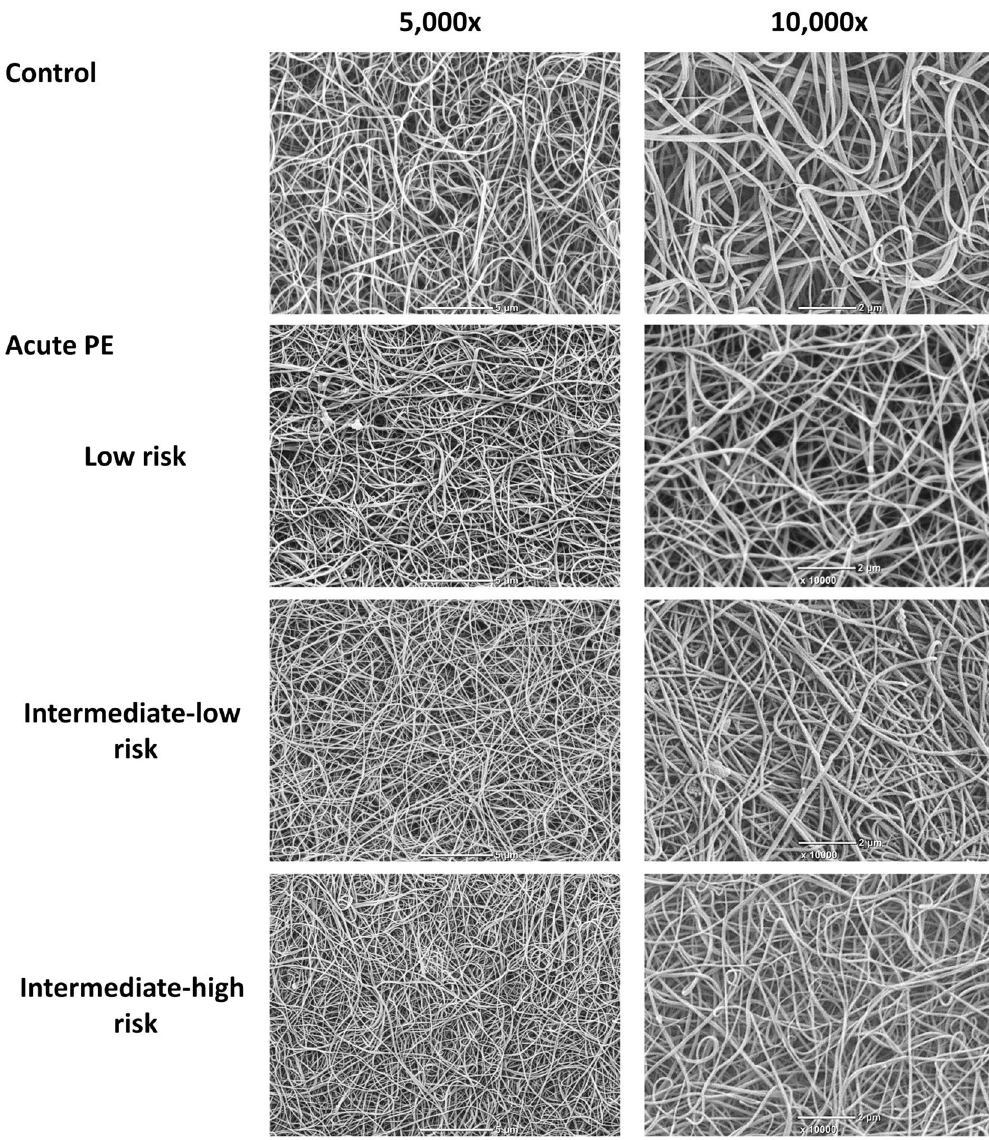
Figure 4. Representative scanning electron micrographs showing morphology of fibrin clots prepared from plasma of healthy control and acute PE patients with similar fibrinogen levels. Scale bar 5 or 2